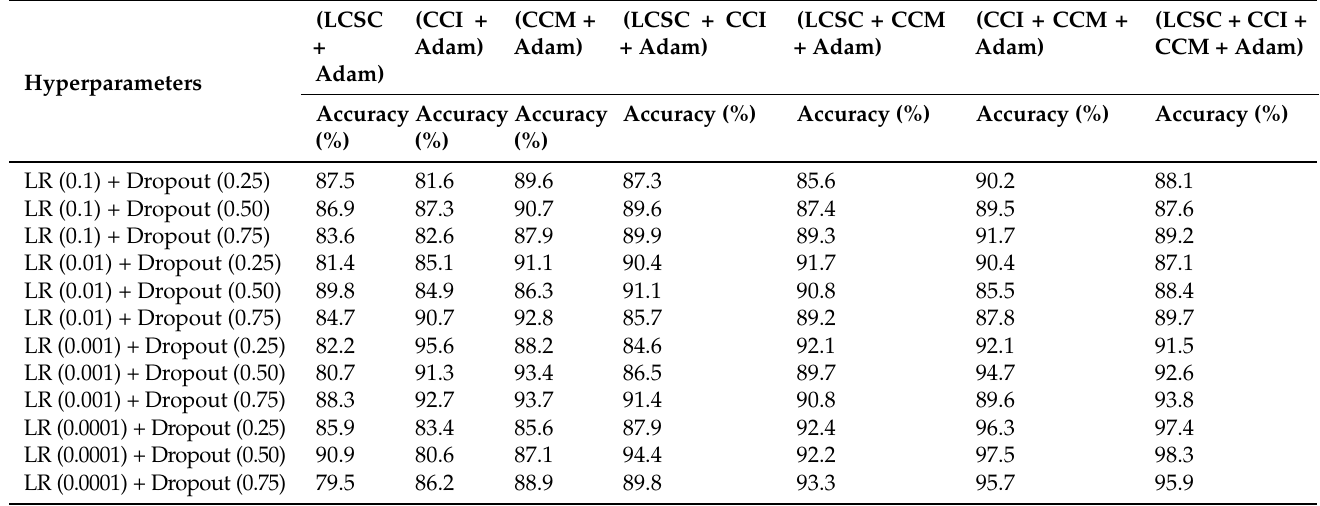
Table 8. Performance evaluation of our proposed model based on different hyperparameter tuning on our dataset with Adam